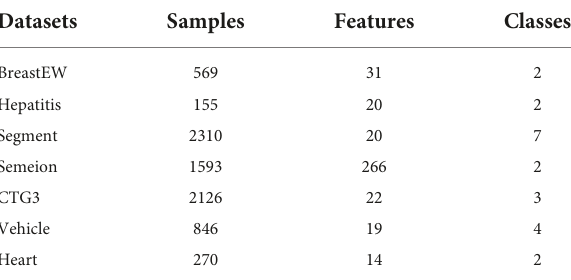
TABLE 10 Key messages from the seven public datasets.